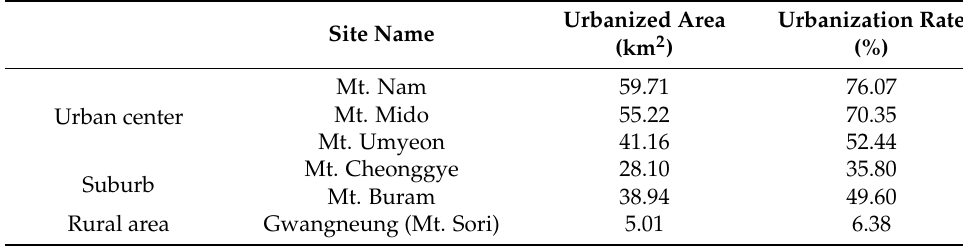
Table 2. Urbanization rate in study sites.